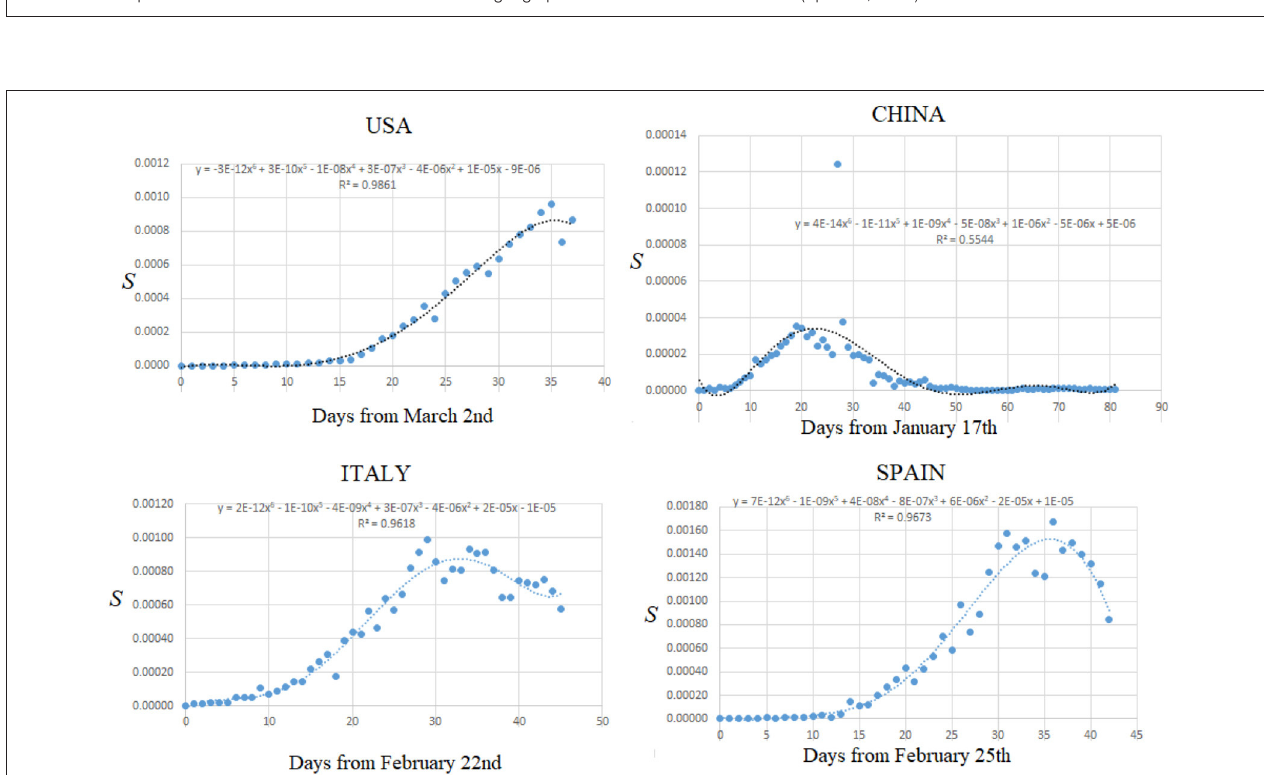
FIGURE 2 | Entropy shape for newly SARS-Cov-2 infected people in relation to the total number of citizens. The best fit allows evaluating the data for maximum infection probability. For the USA this yields new infections to peak on or close to April 28th, for China it results around February 11th; for Italy it yields March 27th; for Spain it results in April 1st. Data recoiled on https://www.ecdc.europa.eu/sites/default/files/documents/COVID-19-geographic-disbtribution-worldwide.xlsx (April 8th, 2020).